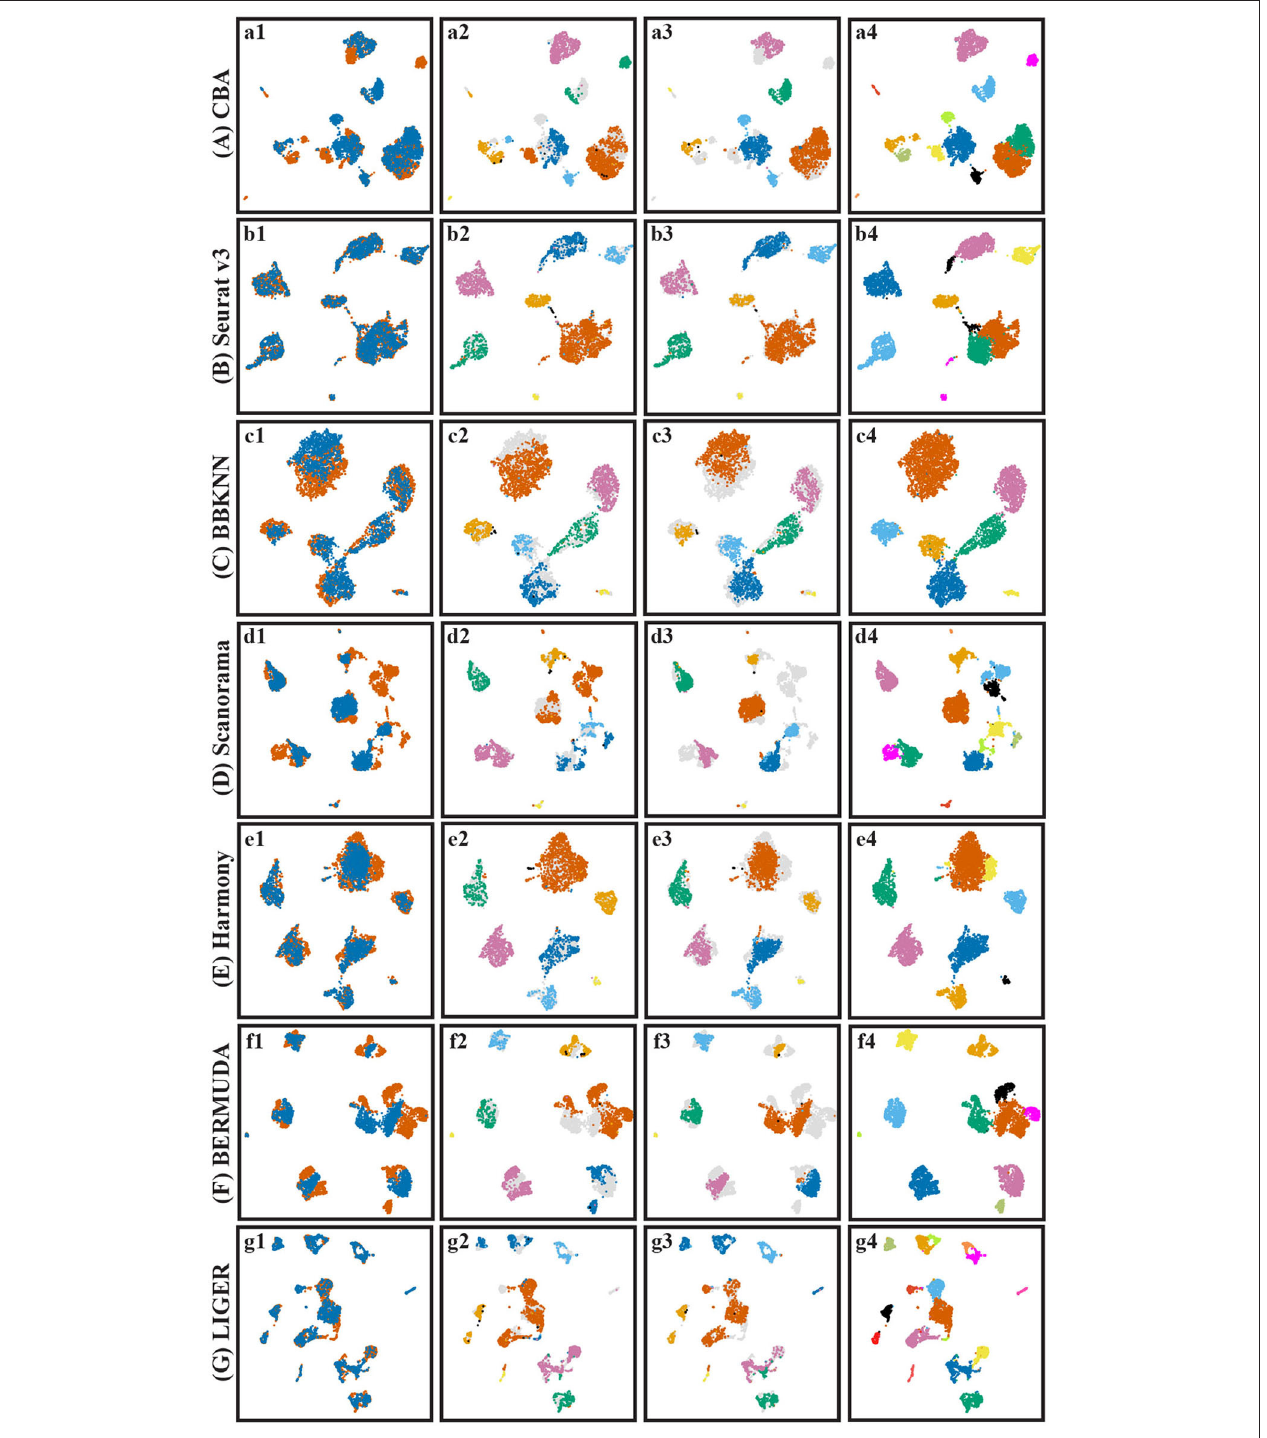
FIGURE 3 | UMAP visualization of different batch effect removal methods for the pancreas datasets. (A–G) Show the different alignment methods: (A) CBA, (B) Seurat v3, (C) BBKNN, (D) Scanorama, (E) Harmony, (F) BERMUDA, and (G) LIGER. For each panel four color codings are shown again: 1) colored according to the batches, 2) colored according to provided clusters in batch one, 3) colored according to provided clusters in batch two, and 4) colored according to Louvain clusters. The provided cell types listed in Figure 2 are only used to evaluate the resulting alignments and not used in the whole aligning process (including the unsupervised clustering in CBA). In *4), the colors of cells are not corresponding with other subfigures since they are obtained by unsupervised clustering, their colors only indicate the distinction of Louvain clusters.